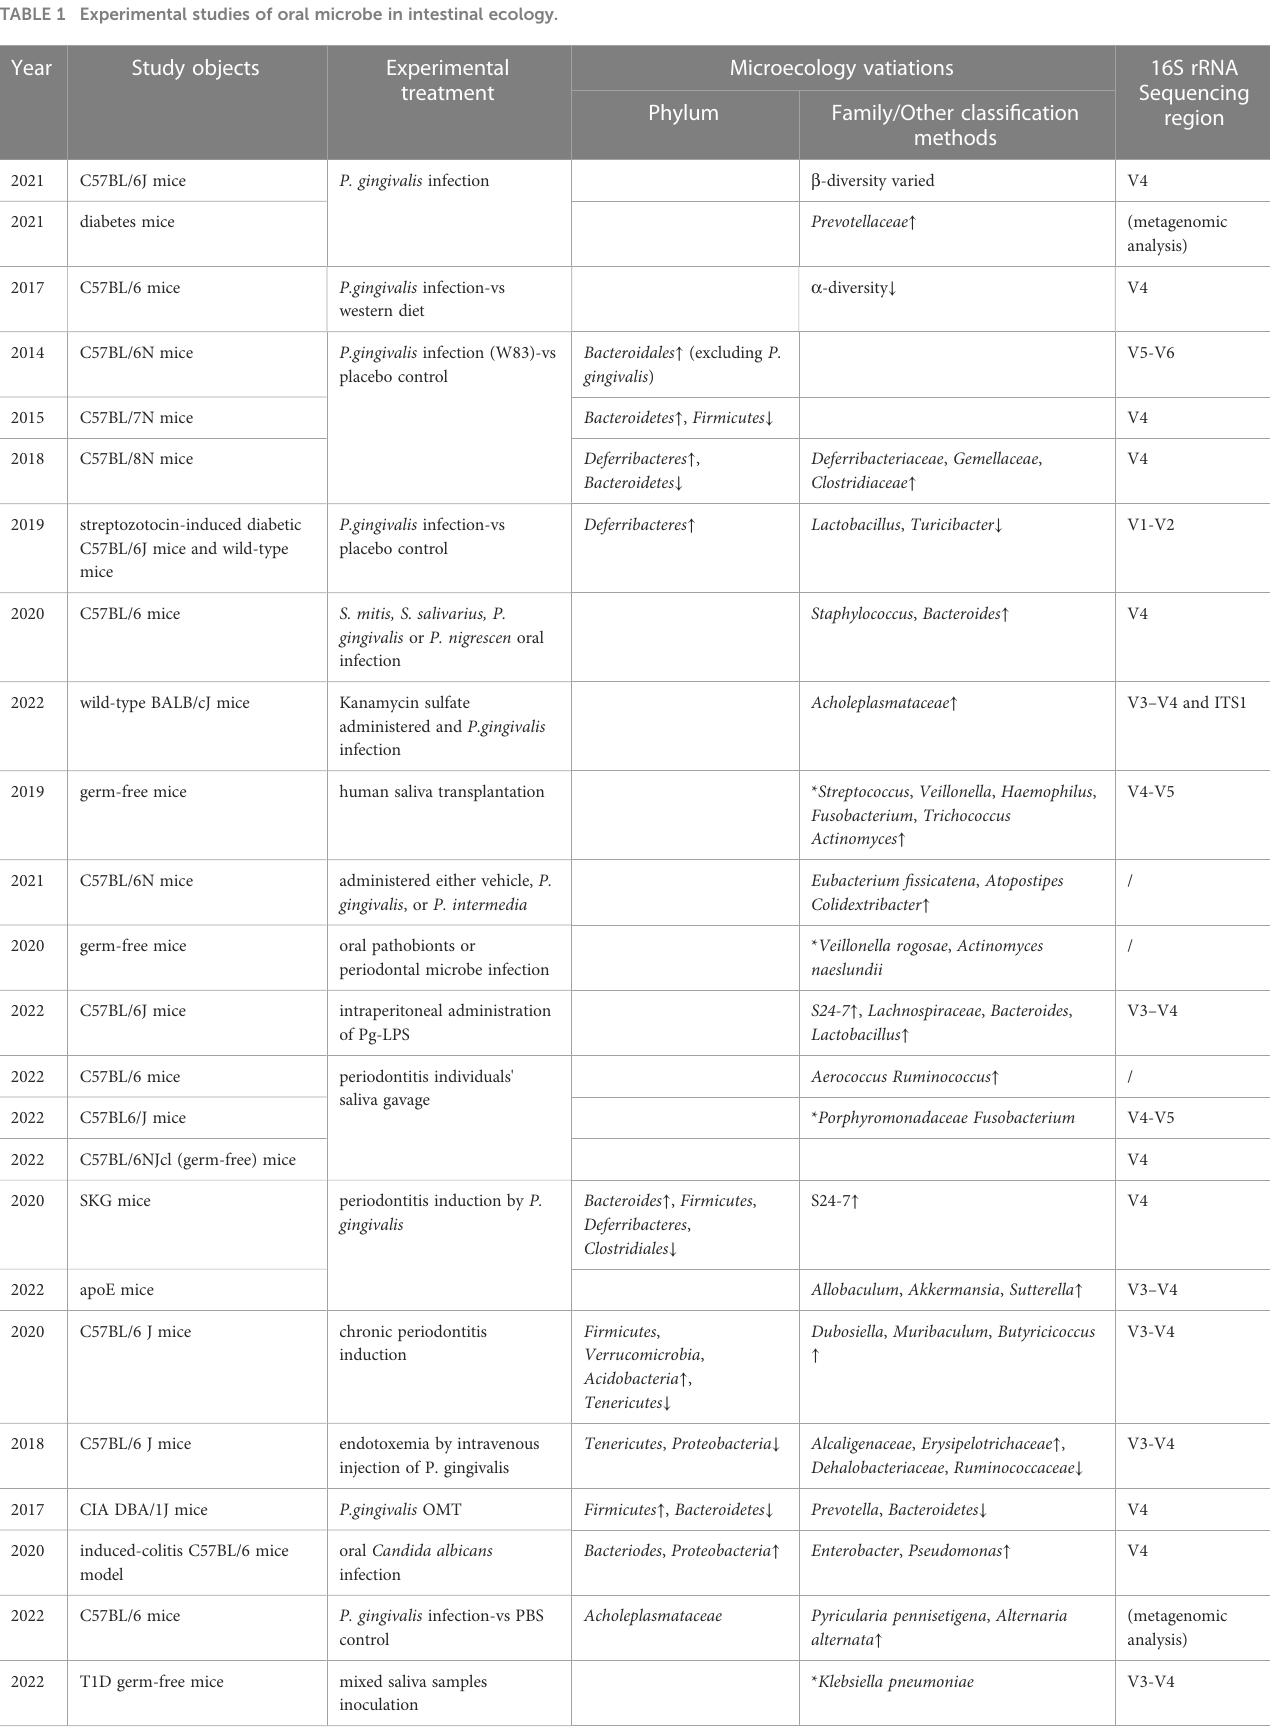
TABLE 1 Experimental studies of oral microbe in intestinal